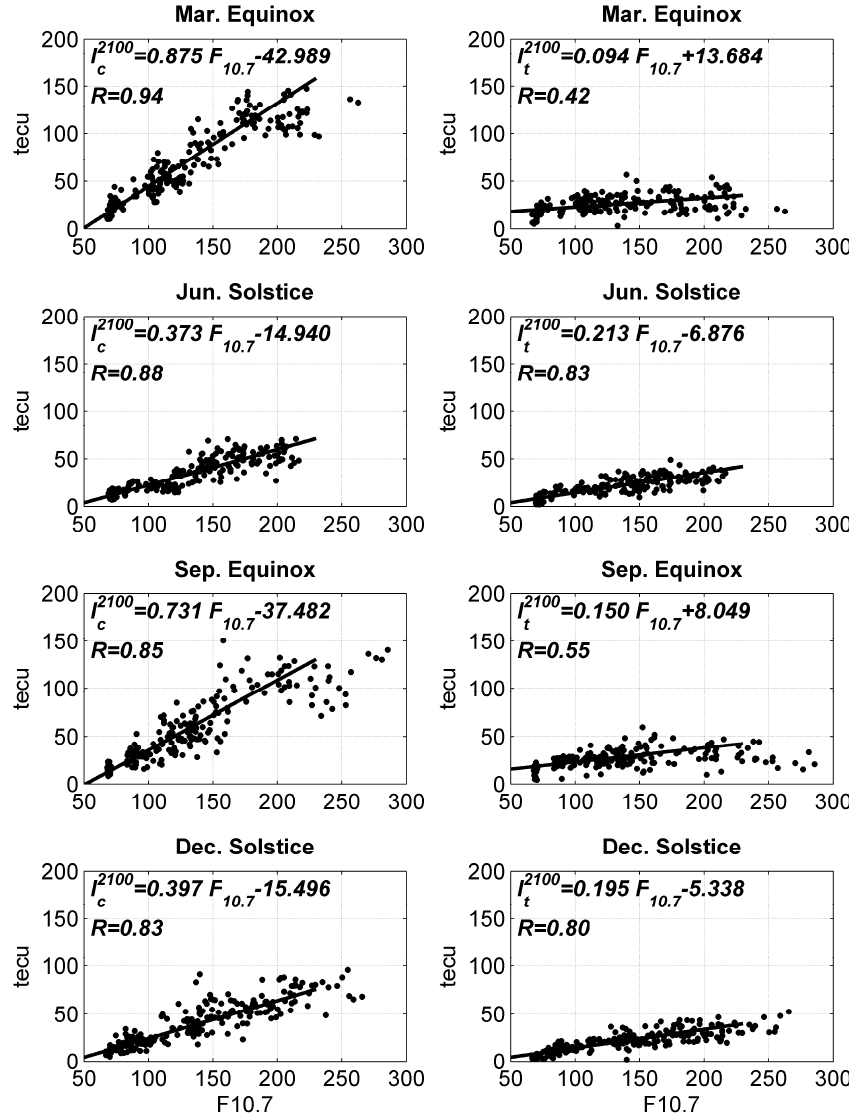
Fig. 6b. Same as Fig. 6a but for the post-sunset sector Figure 6b. Same as Figure 6a but for the post-sunset sector 2100 LT.